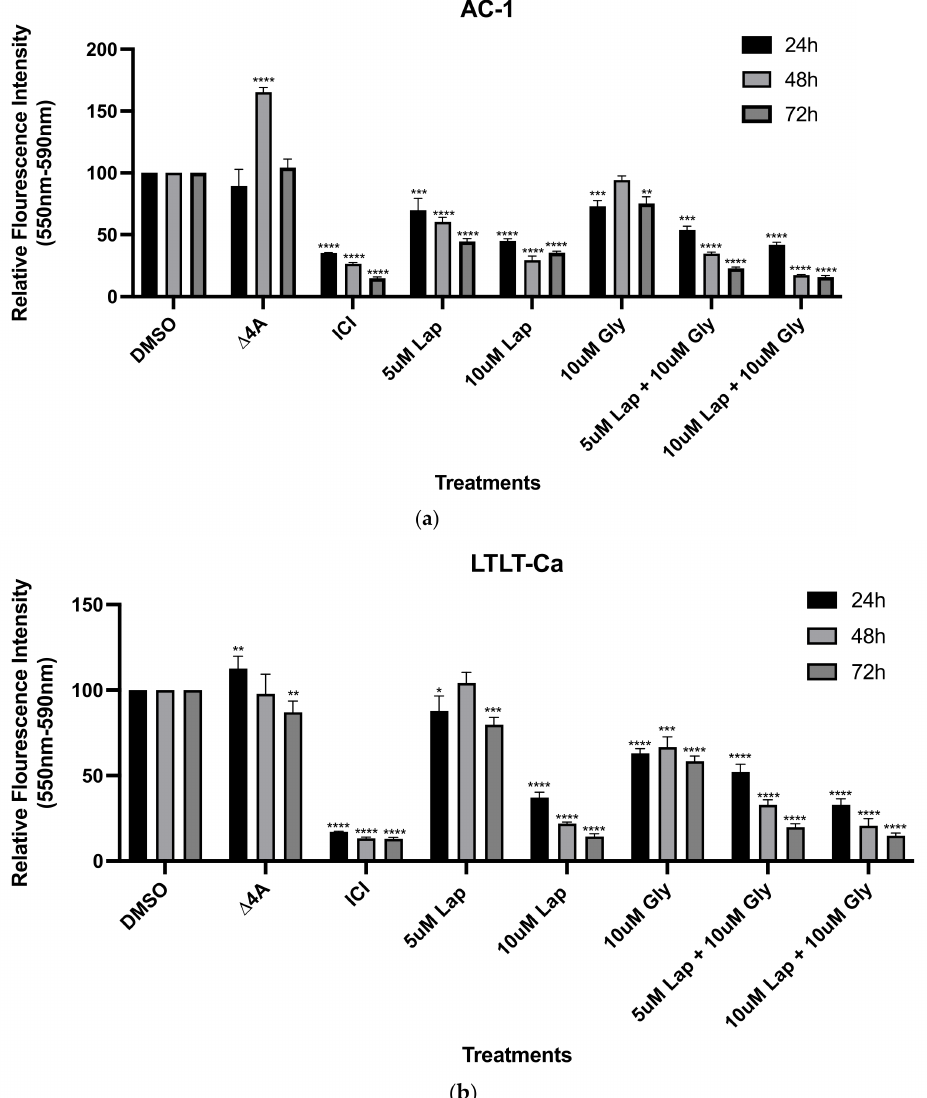
Figure 2. Lapatinib and glyceollin inhibit the proliferation of letrozole-sensitive and letrozole-resistant breast cancer cells. ( a ) The AC-1 cells were cultured in standard growth media and treated with DMSO vehicle control, 25 nM androstenedione ( ∆ 4A), 100 nM ICI (fulvestrant), 10 µ M glyceollin, and 5 µ M or 10 µ M lapatinib ± 10 µ M glyceollin, and cell proliferation assays were performed after 24, 48, or 72 h. ( b ) The LTLT-Ca cells were treated as indicated above. The resazurin assay was conducted and the graphs indicate the fluorescent intensity of cells read at 450/590 nM wavelengths after the indicated time points. Two-way ANOVA analysis were performed, and treatments were compared to the DMSO control. Results are expressed as the mean unit ± SD (**** p < 0.0001, *** p < 0.001, ** p < 0.01, * p < 0.05) of three independent experiments in